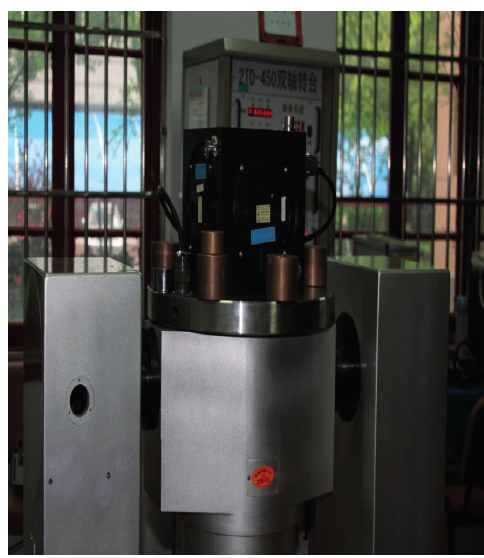
Figure 1. Experimental